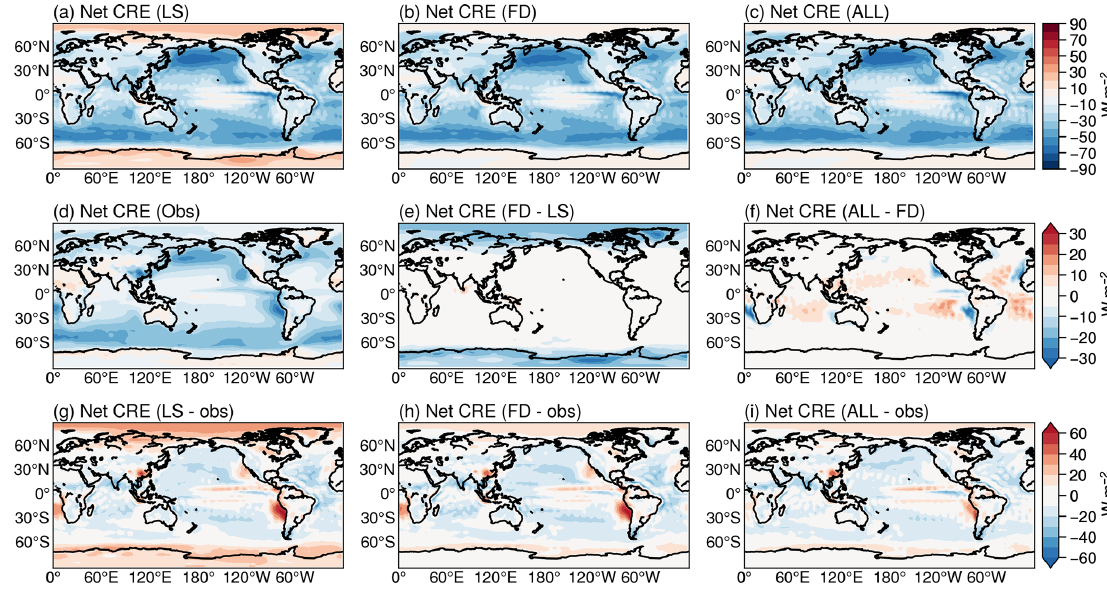
Figure 14. The same as in Fig. 10 but for net CRE (Wm − 2 ) at TOA.